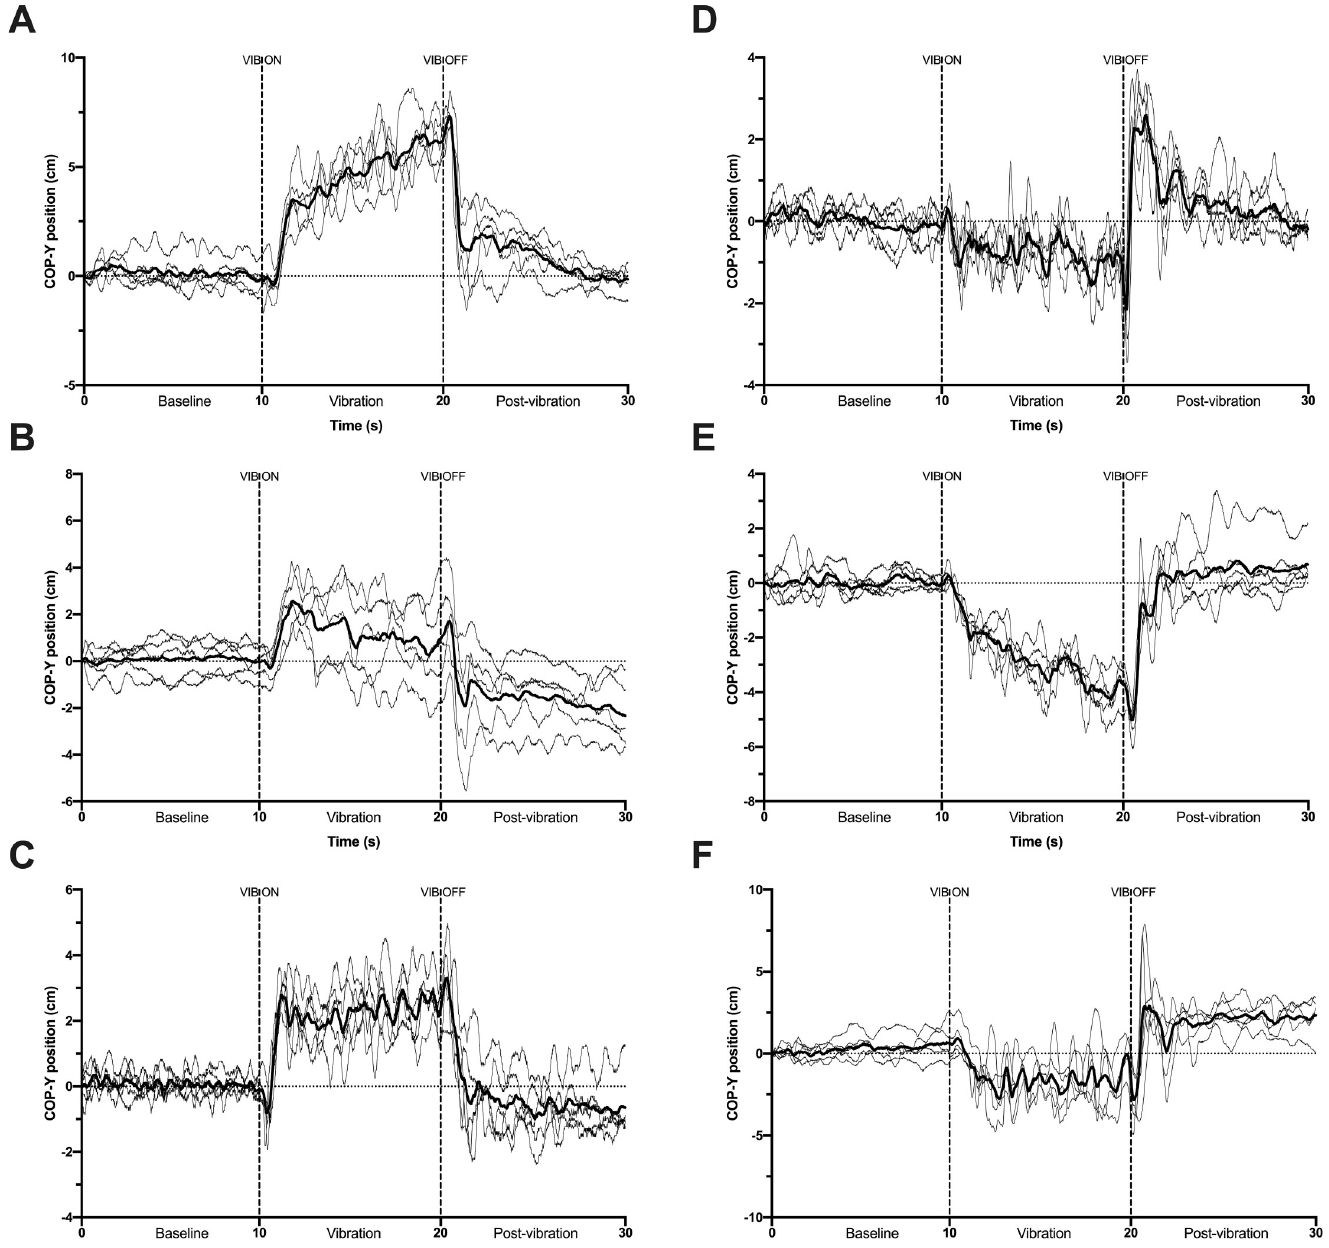
Fig 2. Graphical representation of individual VIB-PR traces for TIB (A-C) and ACH (D-F) conditions. Each graph represents a different participant (the same selected for Fig 1C & 1D), light grey lines represent the five VIB-PR trials and the bold line represents the mean trace calculated from these five trials. VIB = vibration. period. The lowest SEMeas (Fig 3A & 3C) were found for the Last 8 s time-window, except during VIB of ACH which had similar error scores than the Whole 10 s . When these variability metrics were expressed relative to their respective pooled mean (Fig 3B & 3D), contrasts between time-windows became less apparent. The First 2 s mostly remained higher except for Amplitude AP during Post-VIB period of both TIB and ACH conditions which was slightly higher for the Last 8 s . %SEMeas remained mostly between 15–30% of variation (ranging